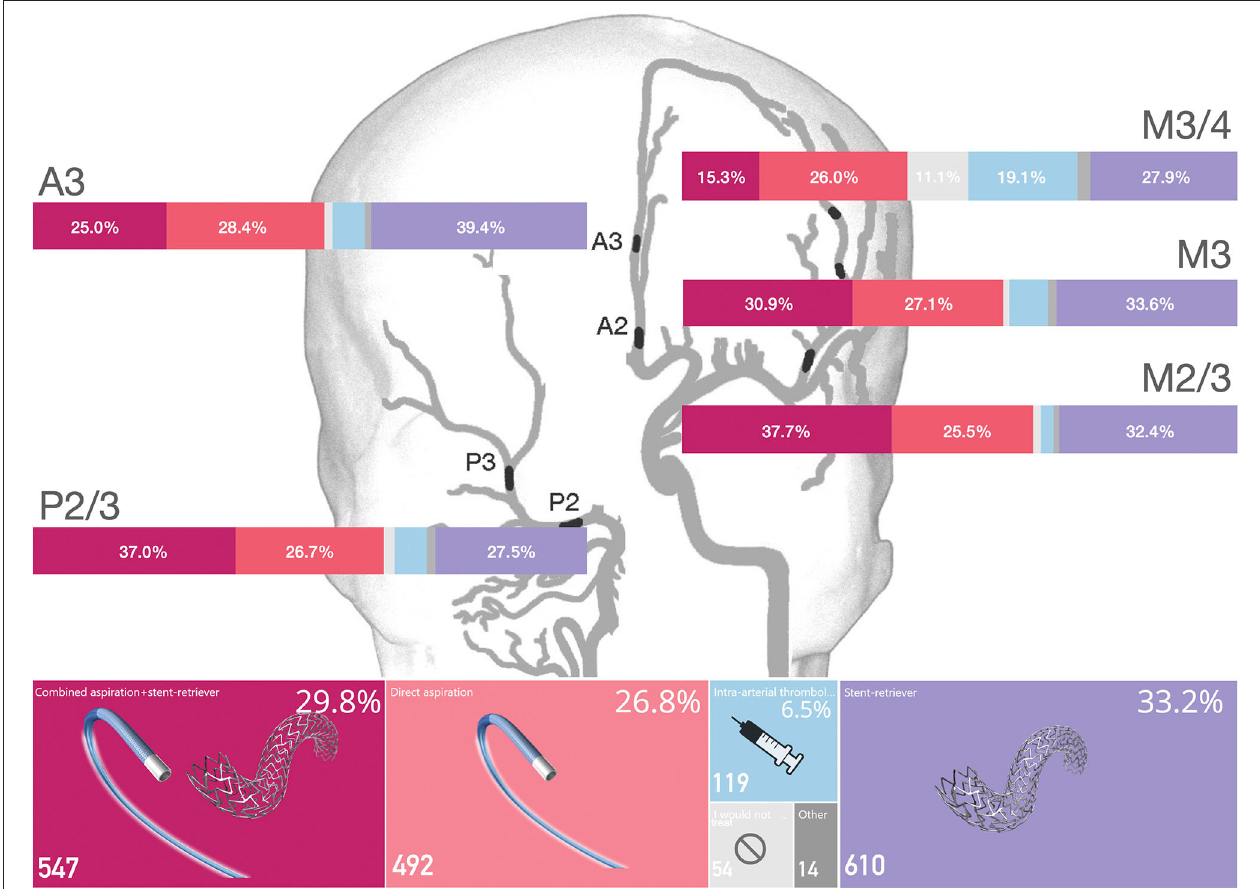
FIGURE 1 | First-line treatment approach by MeVO occlusion site. Overall device usage and proportion of the respondents that chose each treatment approach in each specific vessel is shown in